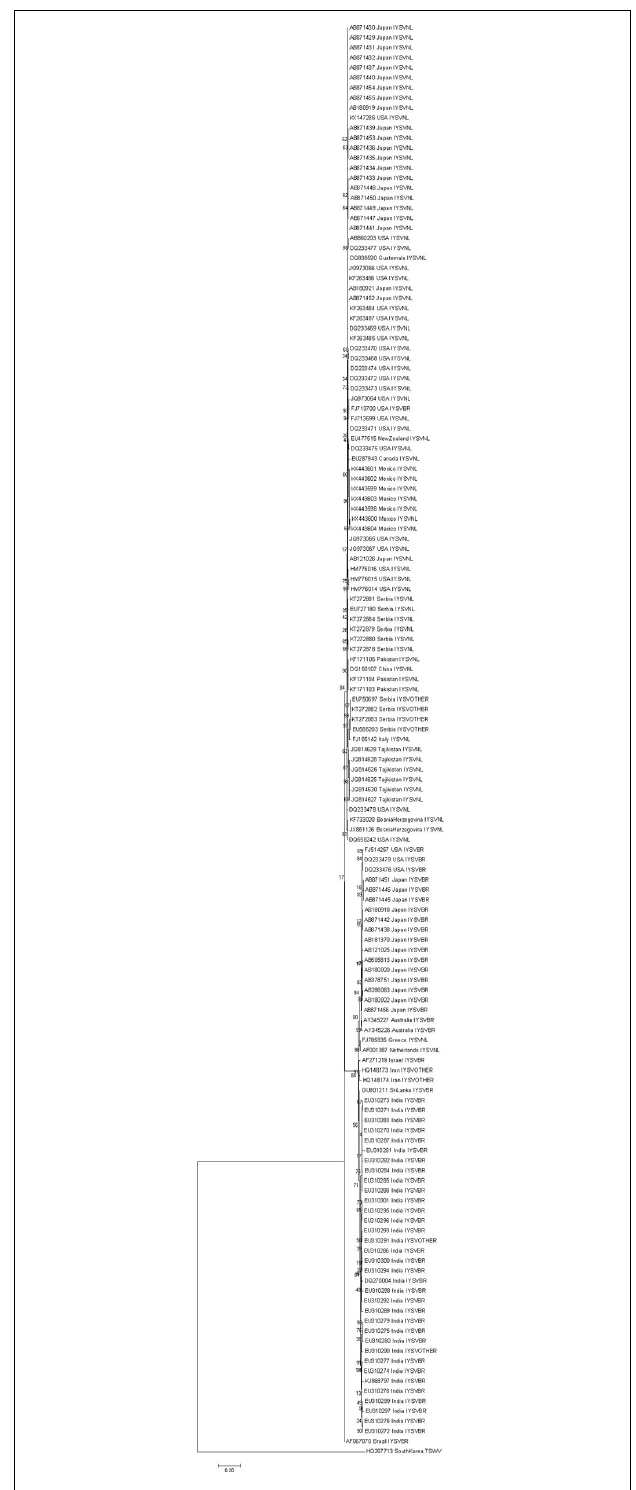
FIGURE 3 | Dendrogram based on the nucleocapsid (N) gene nucleotide sequences of Iris yellow spot orthotospovirus (IYSV). Tomato spotted wilt orthotospovirus N gene isolate HQ267713.1 from South Korea was used as an outgroup. GenBank accession number, place of origin, and IYSV genotype are the indicators of each IYSV